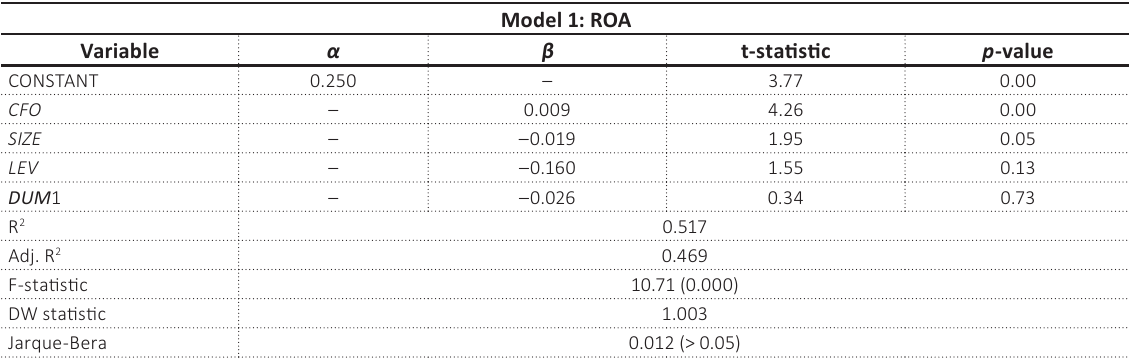
Table 4. Result of regression